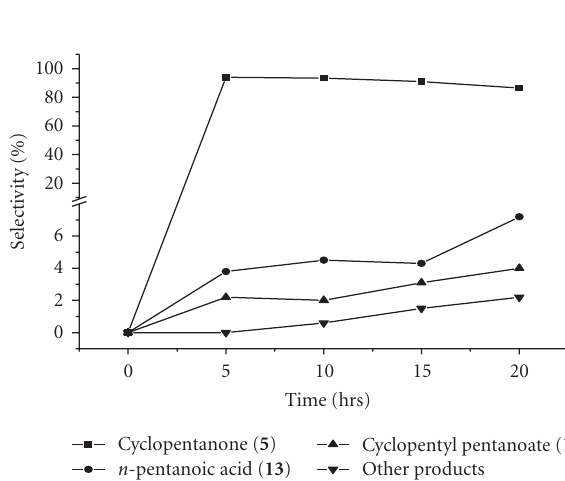
Figure 5: Selectivity of products of PCO of 2 in acetonitrile.